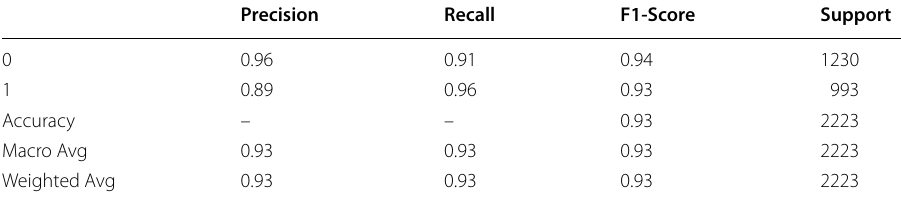
Table 8 Experiment 2 with AraSenTi dataset